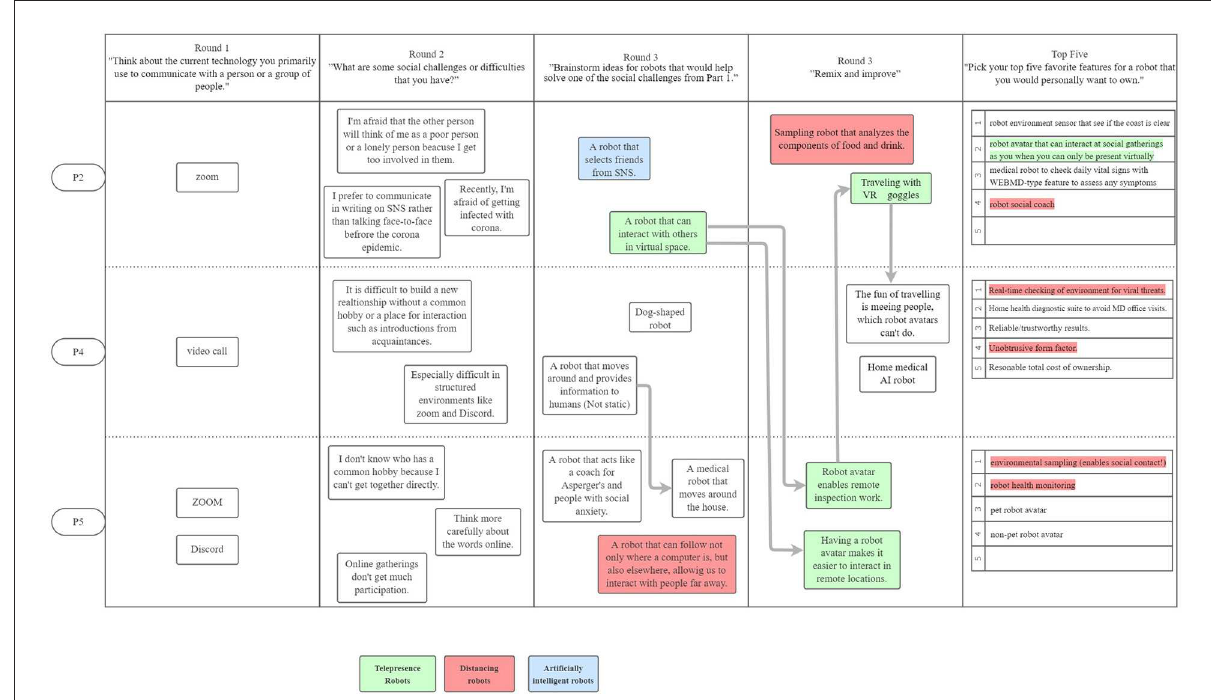
FIGURE1 The first US PD session was held on November 2, 2020 and had 3 participants. The light arrows indicate concepts shared between participants. ”Telepresence robots” and ”distancing robots” were highly